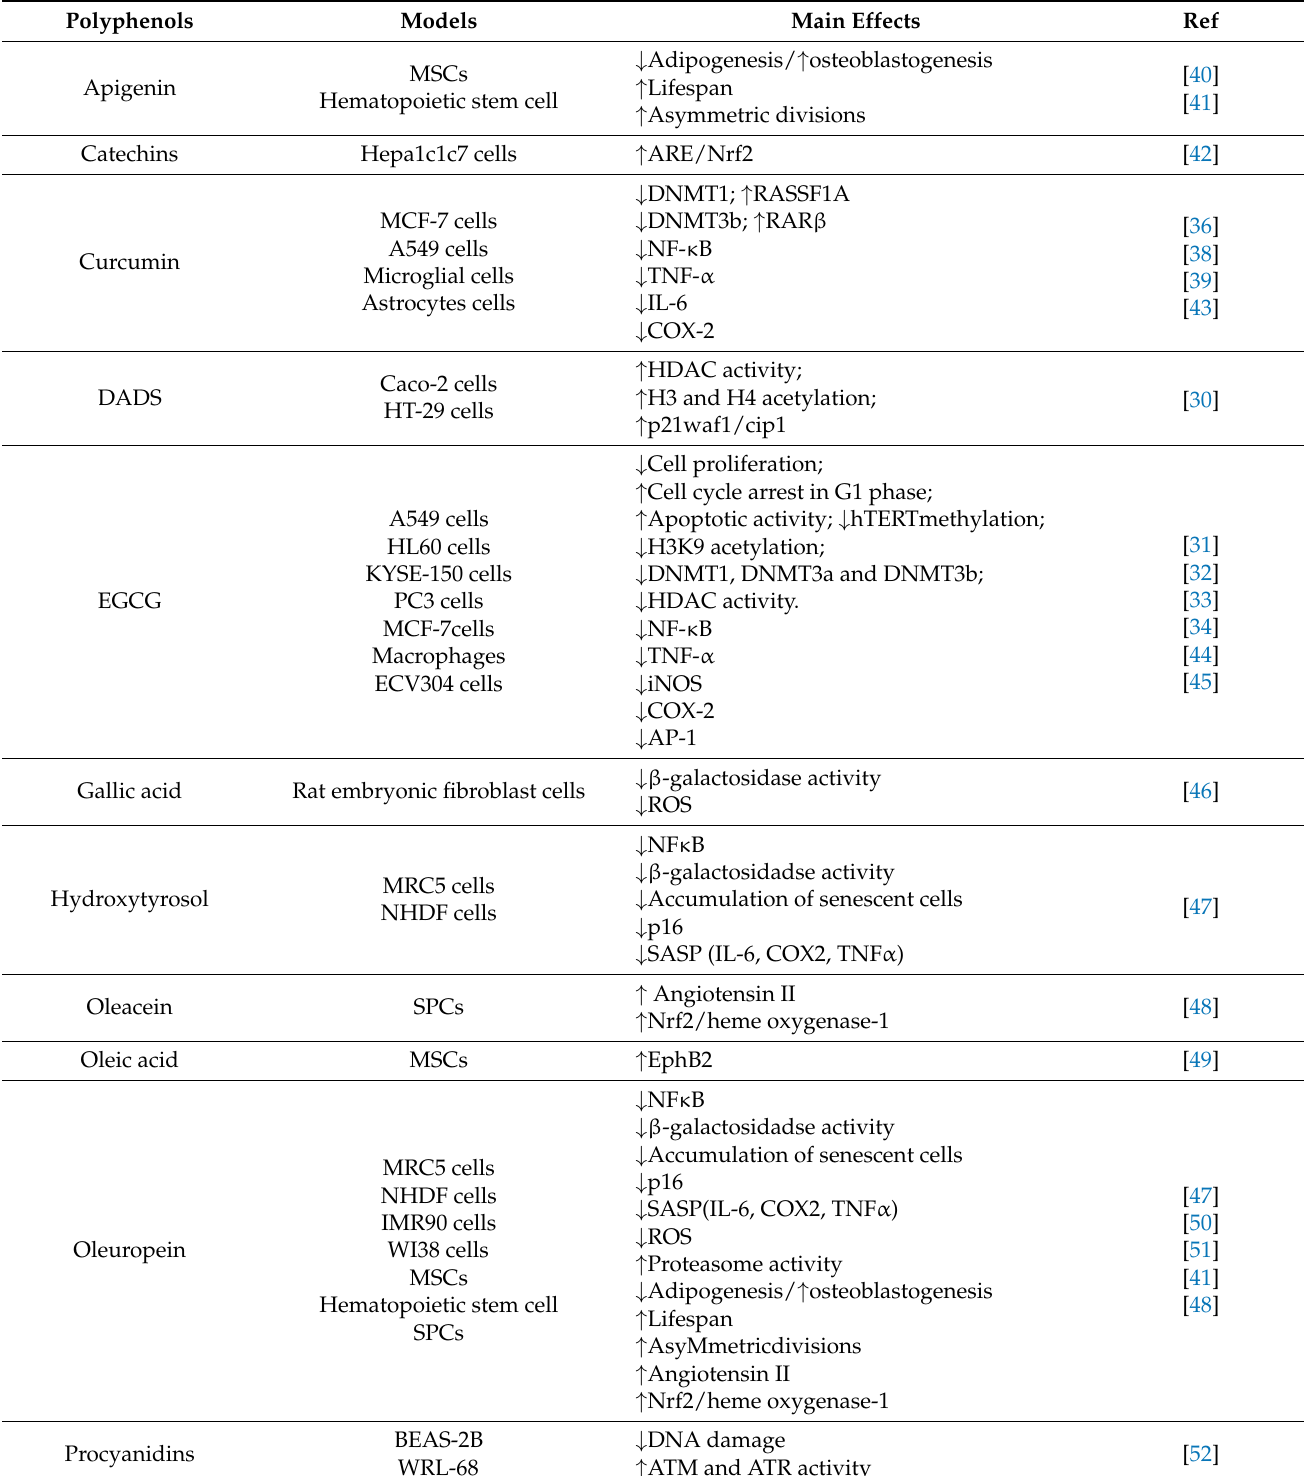
Table 1. The main effects of polyphenols on ageing